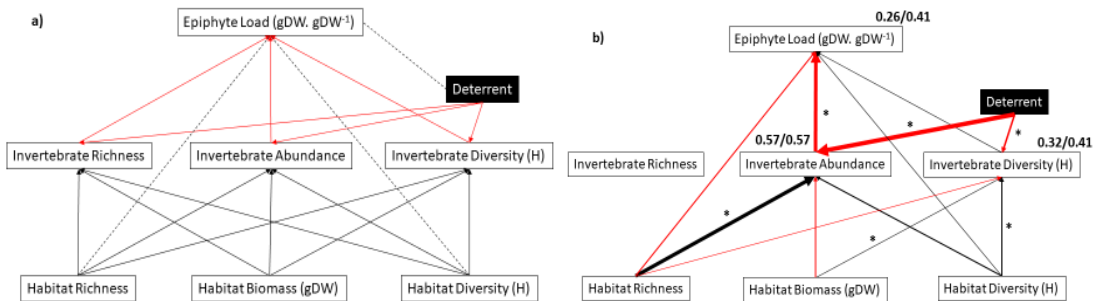
Figure 4. Path analysis of combined interactions. ( a ) Full theoretical interaction web of measured variables and treatment effects and ( b ) final path model. Thickness of positive (black) and negative (red) paths is proportional to their standardised path coefficients. Dashed lines represent indirect paths. Marginal and conditional (respectively) R-squared values are displayed above each of the response variables measured. Primary drivers are indicated by (*).